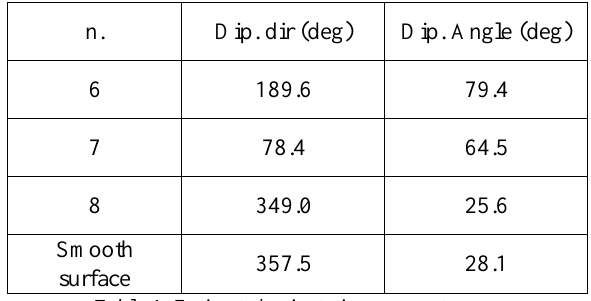
Table 1. Estimated orientation parameters